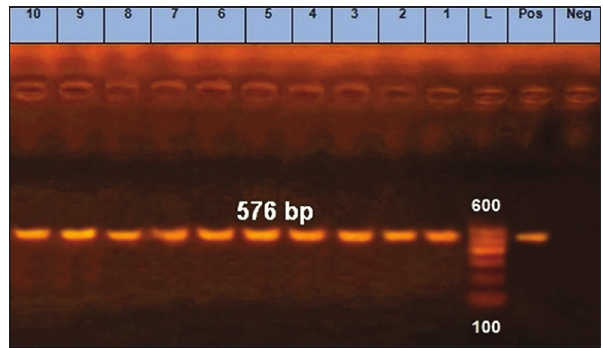
Figure-1: Polymerase chain reaction results of amoxicillin- resistant Escherichia coli isolates ( bla 1 to 10 depict positive amplification of the bla 516 pb, Neg=Negative control, Pos=Positive control,